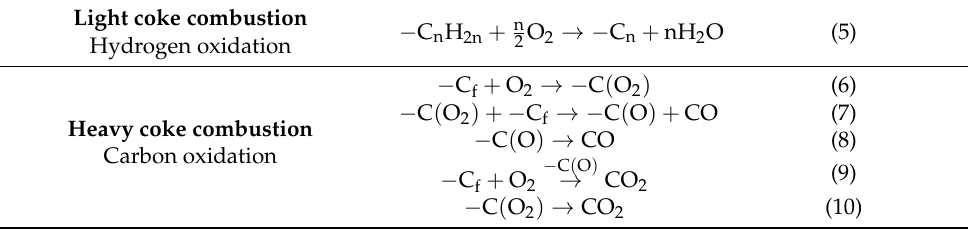
Table 1. Overall mechanism for light and heavy coke oxidation with